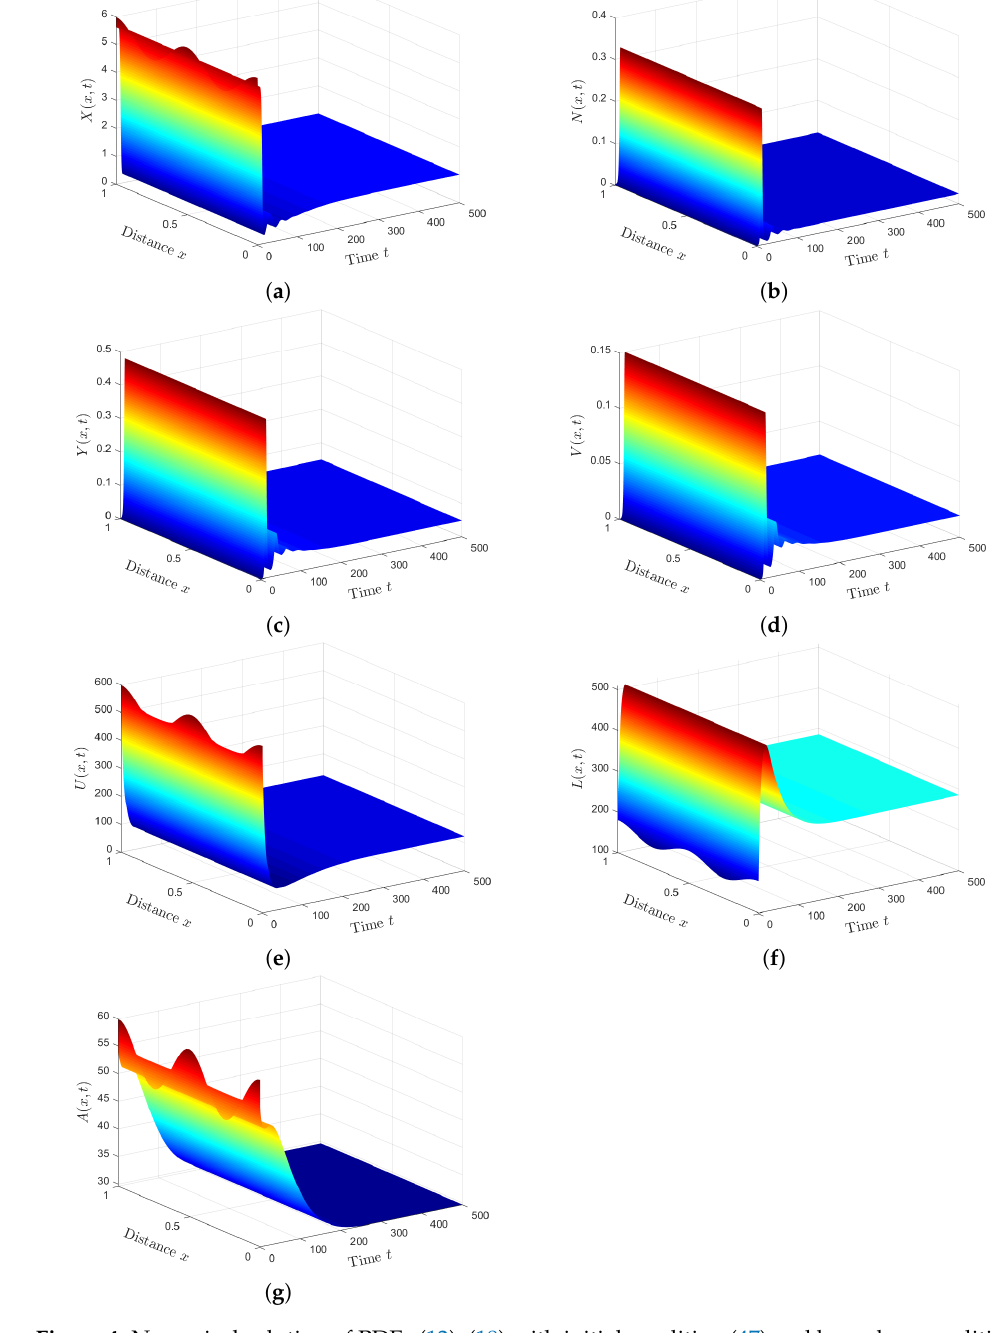
Figure 4. Numerical solution of PDEs (12)–(18) with initial condition (47) and boundary condition (48) in Plan (IV). ( a ) Healthy ECs. ( b ) Latent infected ECs. ( c ) Active infected ECs. ( d ) SARS-CoV-2. ( e ) Healthy T cells. ( f ) Latent infected T cells. ( g ) Active infected T